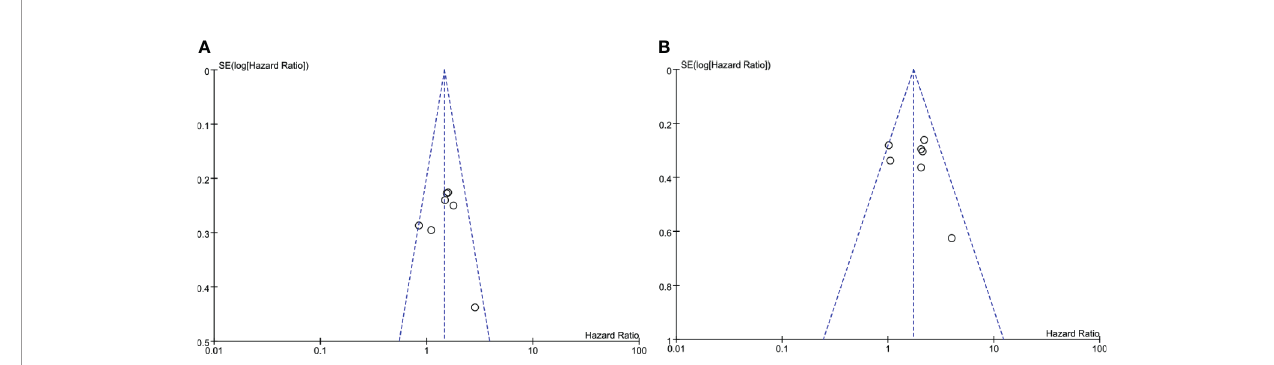
FIGURE 6 | Funel plot of impact of publication bias. (A) Sarcopenia and PFS (by multivariate HR), (B) Sarcopenia and OS (by multivariate